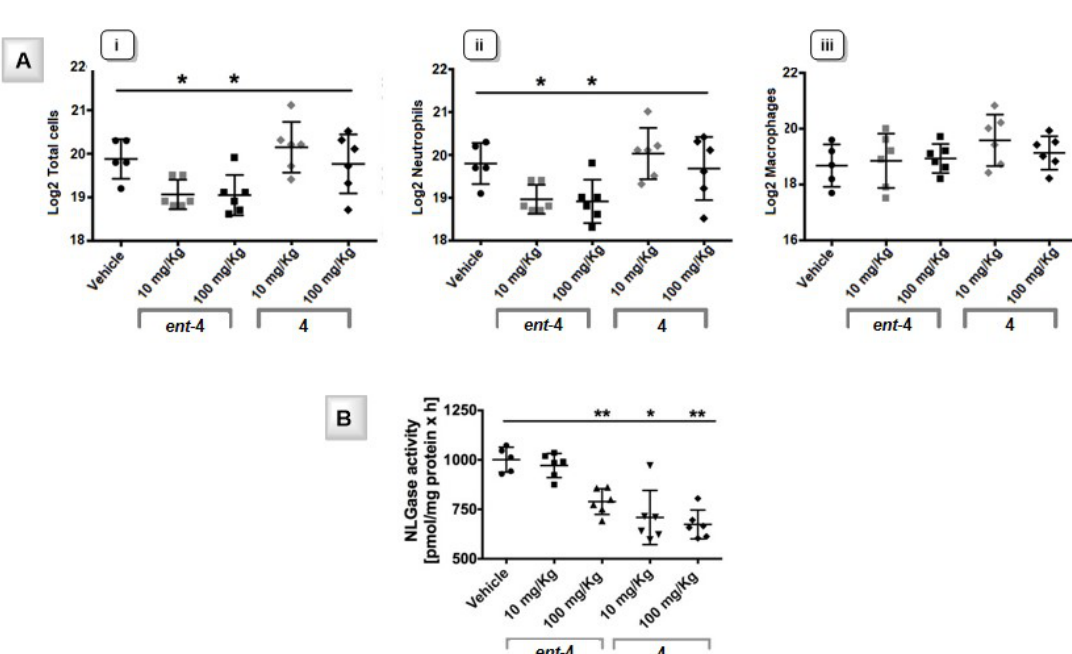
Figure 24. ( A ) Effect of 4 and ent - 4 on cells recruited in bronchoalveolar lavage (BAL) of C57Bl/6NCr mice infected by P. aeruginosa (i, total cells; ii. neutrophils; iii. alveolar macrophages). ( B ) NLGase activity in the lungs of mice infected by P. aeruginosa. * p < 0.05; ** p < 0.01. This figure was reprinted from [179], with permission from Elsevier.